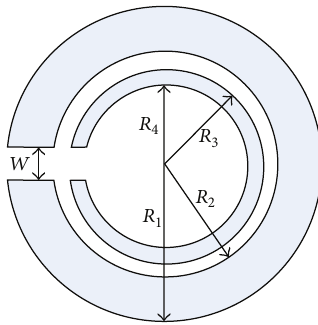
Figure 1: The geometry of the proposed defected ground structure.